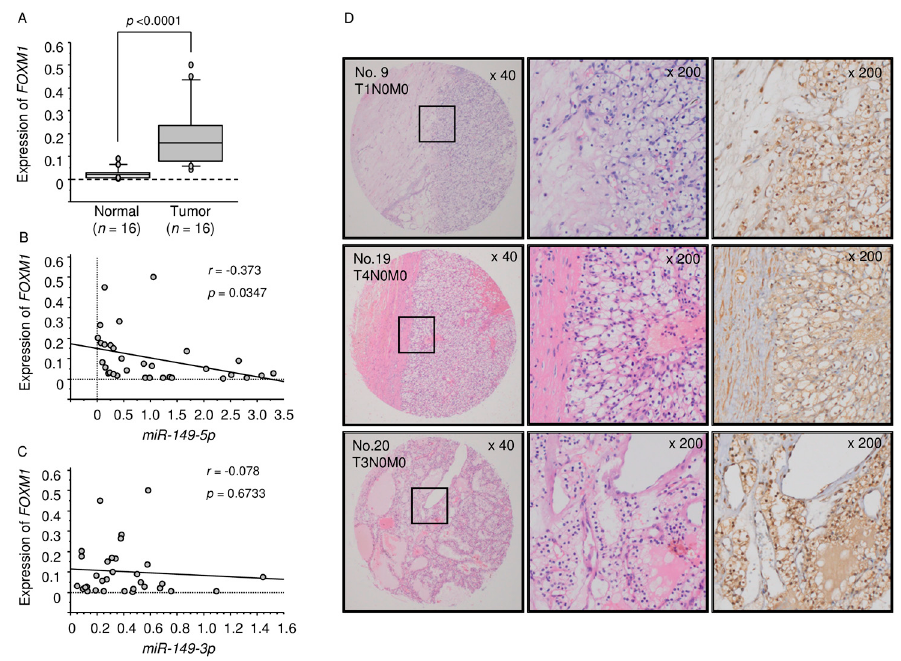
Figure 4. Expression levels of FOXM1 in ccRCC clinical specimens and TCGA data analysis based on FOXM1 expression in ccRCC. ( A ) Expression levels of FOXM1 in ccRCC specimens were significantly upregulated in cancer tissues compared with normal tissues ( p < 0.0001); ( B , C ) The correlation between FOXM1 and miR-149-5p , and FOXM1 and miR-149-3p and ( D ) FOXM1 protein was strongly expressed in several cancer tissues, while low expression was observed in normal tissues using a tissue microarray.